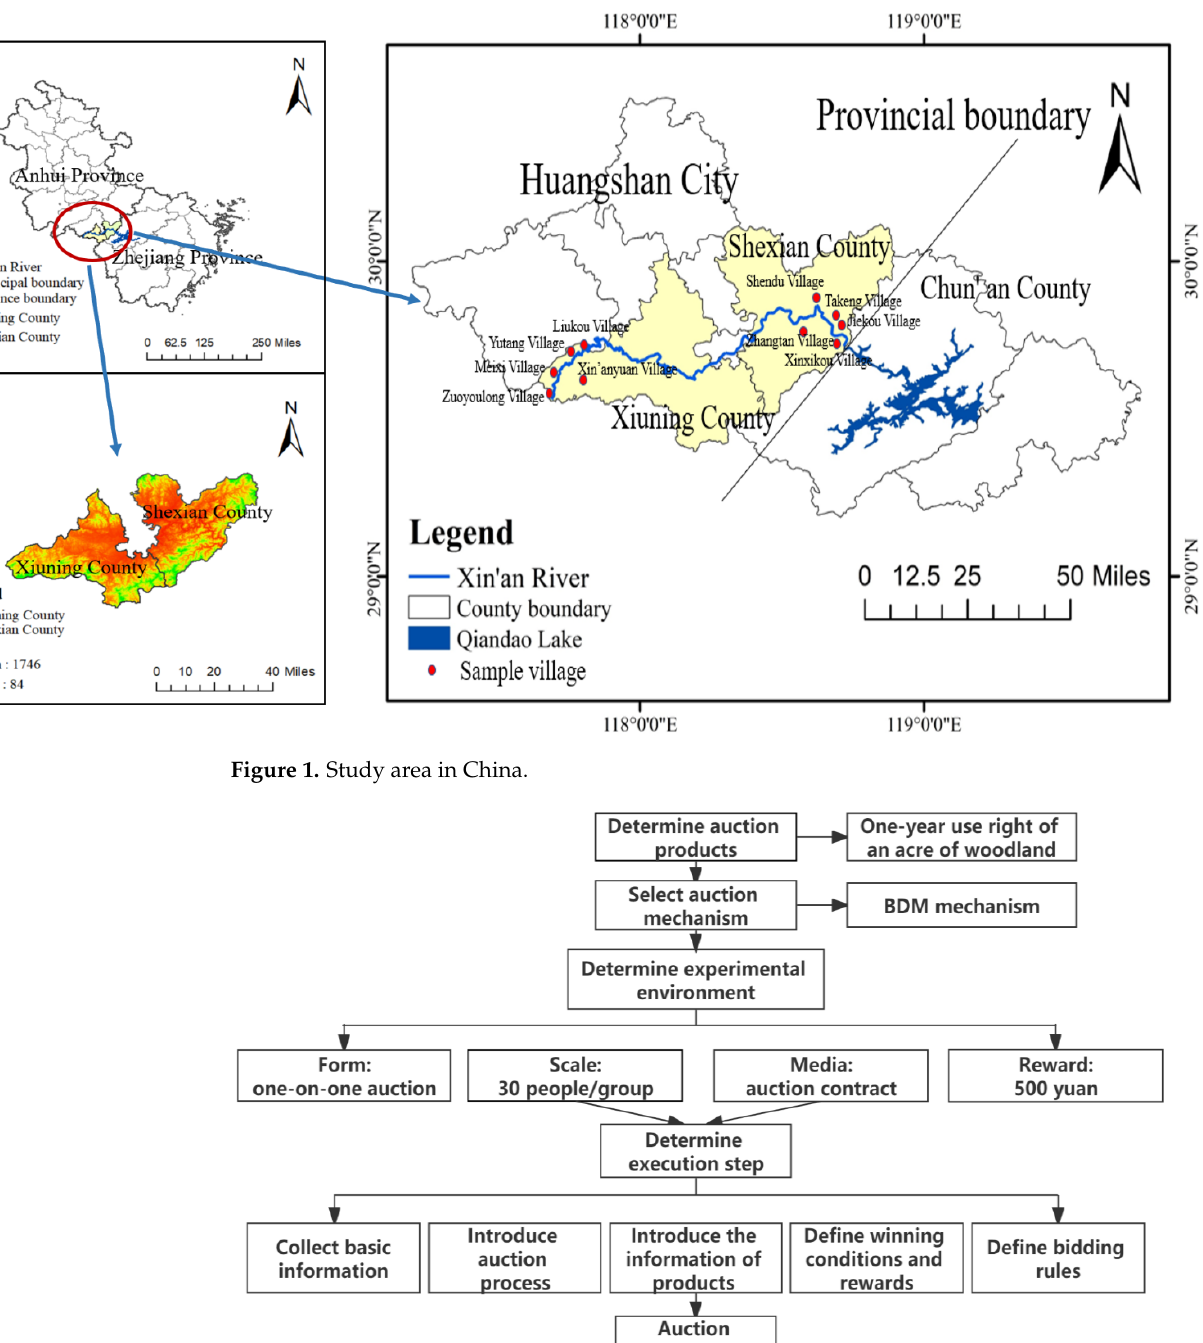
Figure 2. Auction experimental design framework.